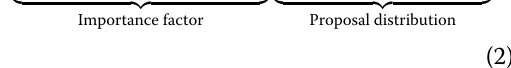
then, using the Bayesian rule and Markov assumption, the ( i ) weight of importance w t equation for RBPFs based on GPS and LIDAR in Eq. (4) becomes